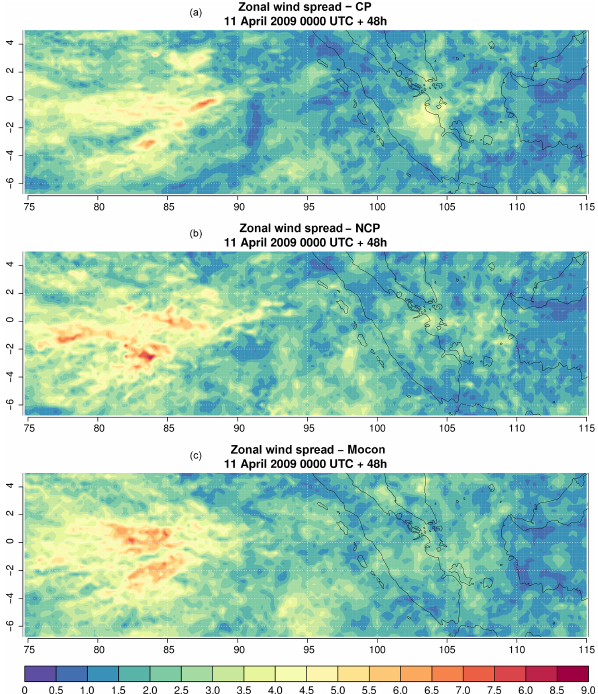
Figure 14. Snapshot of the zonal wind spread (ms − 1 ) at 250hPa. Snapshot is taken at verification date 00:00UTC on 13 April 2009 (lead time 48h) for the CP (a) , NCP (b) and MOCON (c) ensem- bles, all with IC and LBC